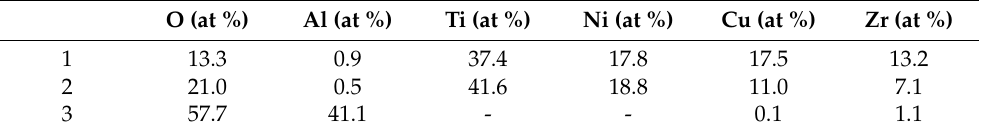
Table 5. Composition (at %) measured by means of EDS analysis of the points and areas indicated in Figure